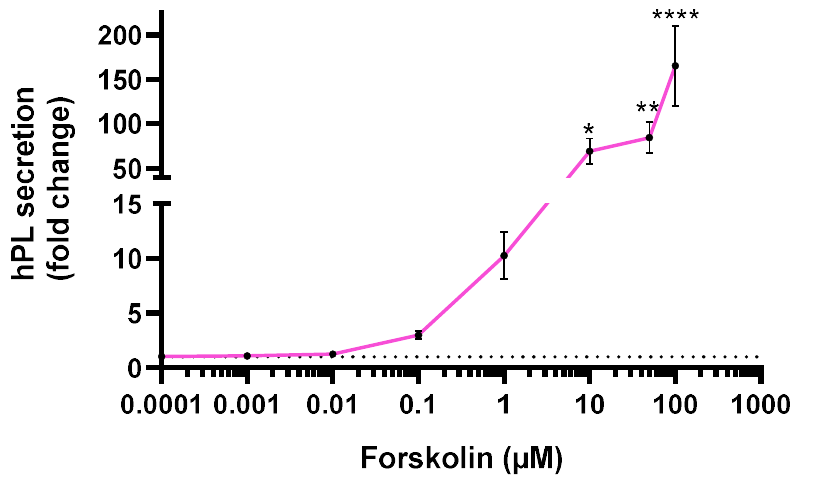
Figure 5. hPL secretion after a 72-h incubation time with forskolin. The dotted line represents the hPL basal secretion. The significance thresholds were * p < 0.05, ** p < 0.01 and **** p < 0.0001 compared to the culture medium.